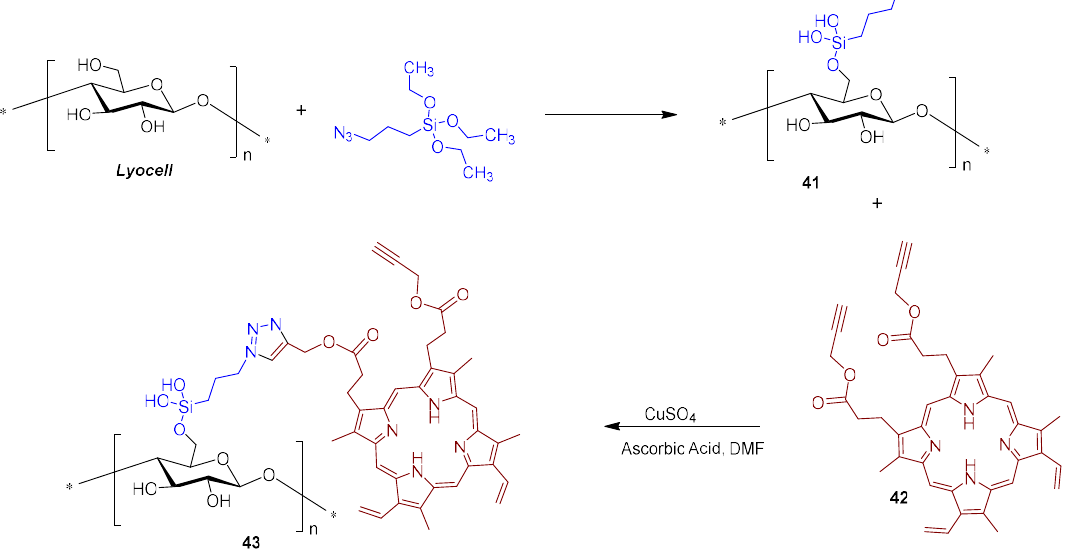
Figure 31. Synthetic route to immobilize alkynylated PPIX 42 on alkoxysilane azido-modified Lyocell fibers 41 (adapted from Ref. [121] ).